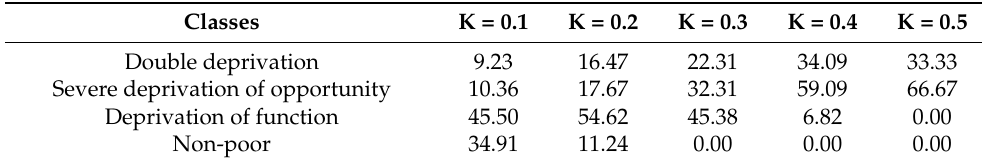
Table 5. Cross-table of multiple deprivation categories and A–F method results (%).